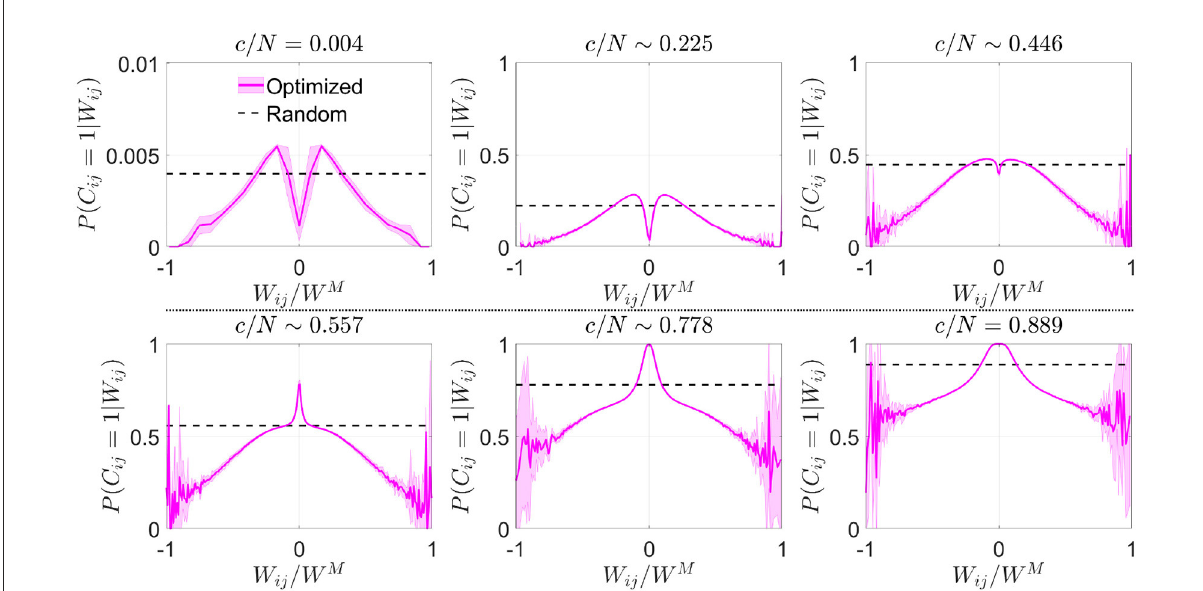
FIGURE2 Optimization by noise reduction avoids connections with high absolute synaptic weight. Distribution of the conditional probability of having a connection between two neurons given their associated Hebbian weight for optimized (magenta; mean ± s.d.; N = 5,000) or random (dashed black; theoretical mean) networks. Each panel corresponds to a different connectivity value (indicated). Note that in some cases fluctuations are observed close to | W ij / W M | ∼ 1, which are caused by a low number of available data points for extreme values of synaptic weight. Pool of data corresponding to five simulations for each